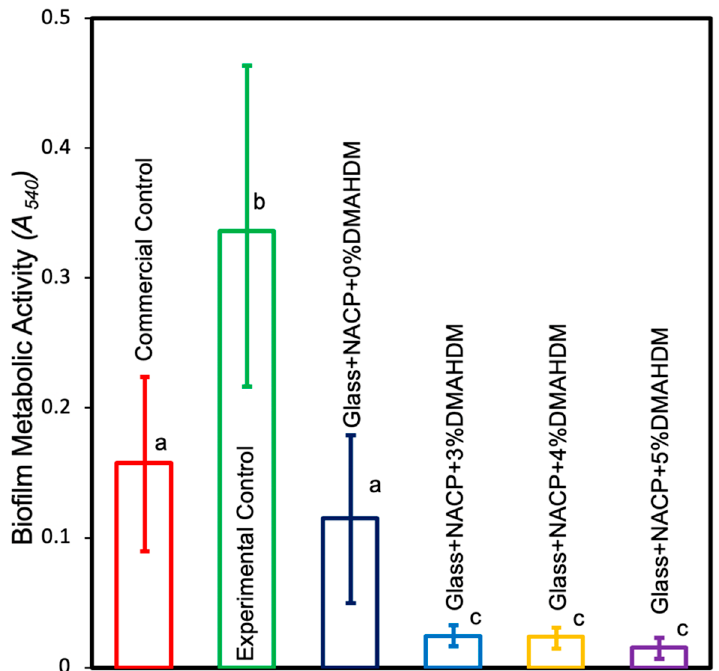
Figure 7. Metabolic activity for 2-day S. mutans biofilms on resin cement disks (mean ± SD; n = 4).